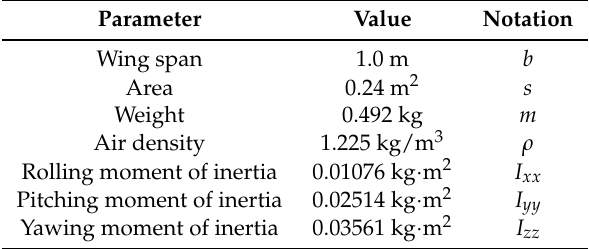
Table 1. Unmanned aerial vehicles (UAV) parameters.